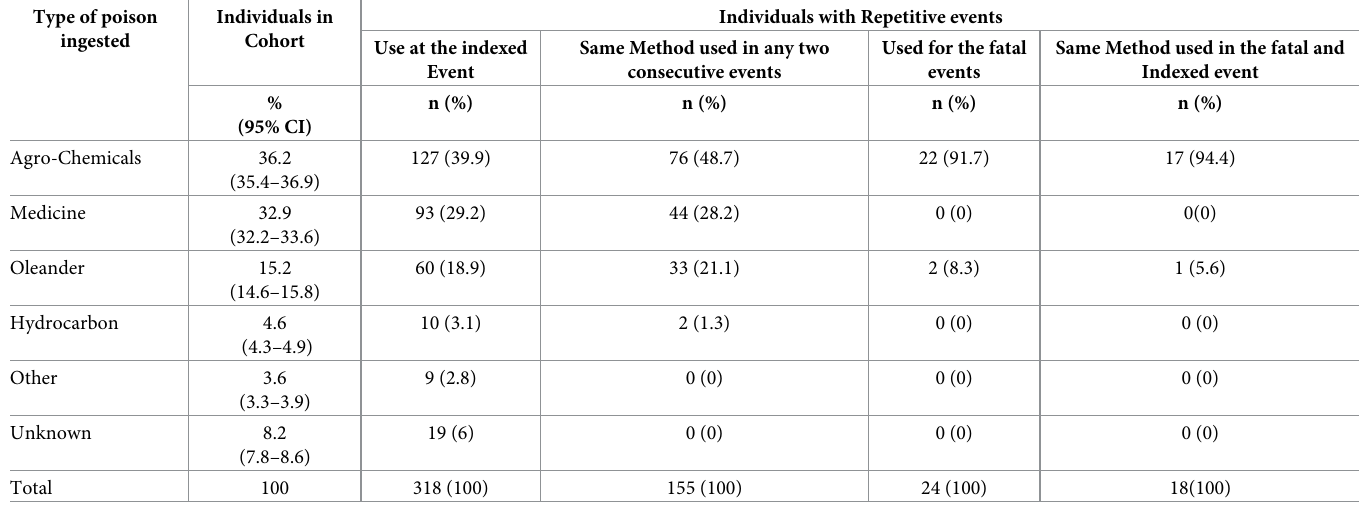
Table 3. Fatal and non-fatal repetitive events reported to hospitals by the type of the poison and pattern of use at subsequent events. Type of poison Individuals in Individuals with Repetitive events ingested Cohort Use at the indexed Same Method used in any two Used for the fatal Same Method used in the fatal and Event consecutive events events Indexed event n